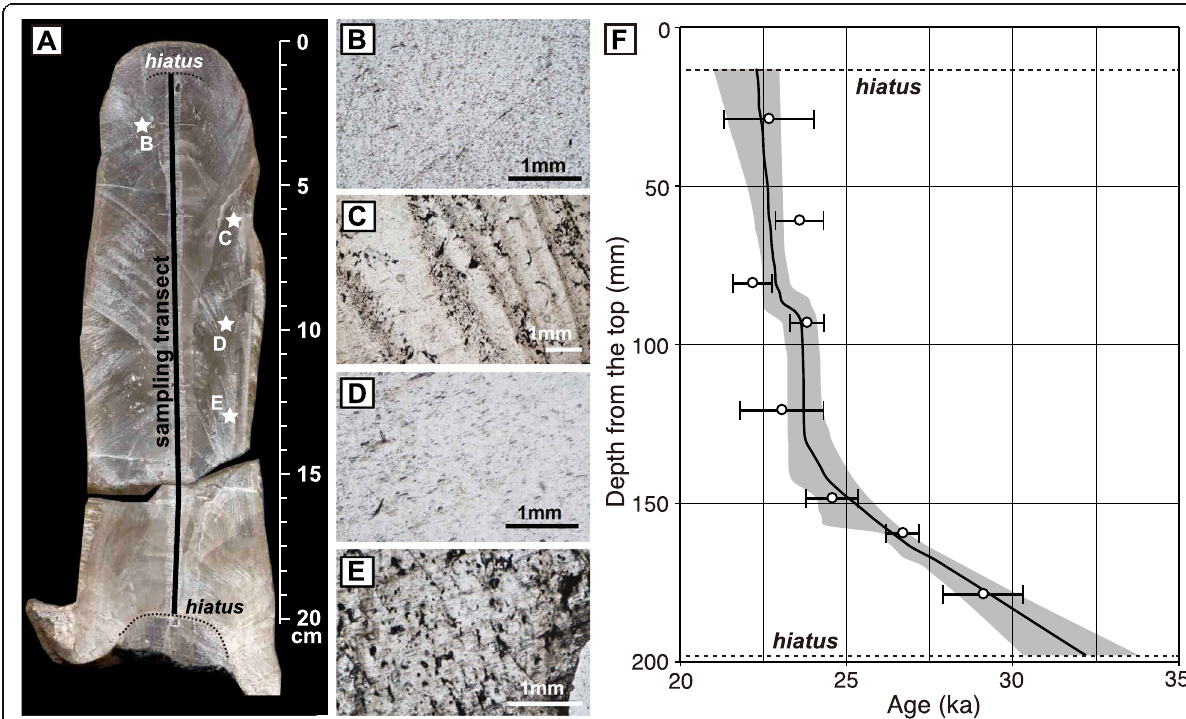
Fig. 2 Textures and age model of FG02. a The half-cut specimen of FG-02 showing sampling transect of isotopic analysis and positions of thin section image. Two hiatus horizons are indicated by dotted lines. b Transparent calcite at 3.5 cm from the top. c Millimeter-scale layering at 6.5 cm from the top. d Transparent calcite at 9.7 cm from the top. e Vague-layered structure at 13.5 cm from the top. f Age model: the length of the stalagmite, starting from the top, is plotted against age. Measured ages are presented with error bars of 2 σ . The black line represents the smoothed age data, while the gray-shaded region represents the error range calculated using StalAge (Scholz and Hoffmann